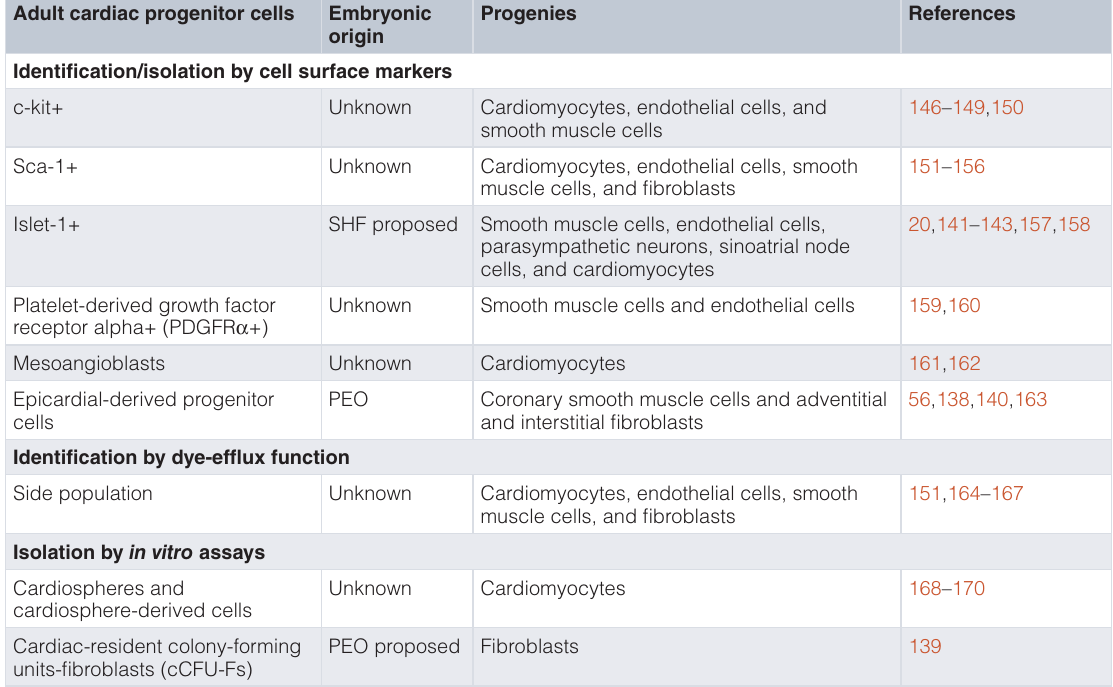
Table 1. Different identified adult cardiac progenitor cell